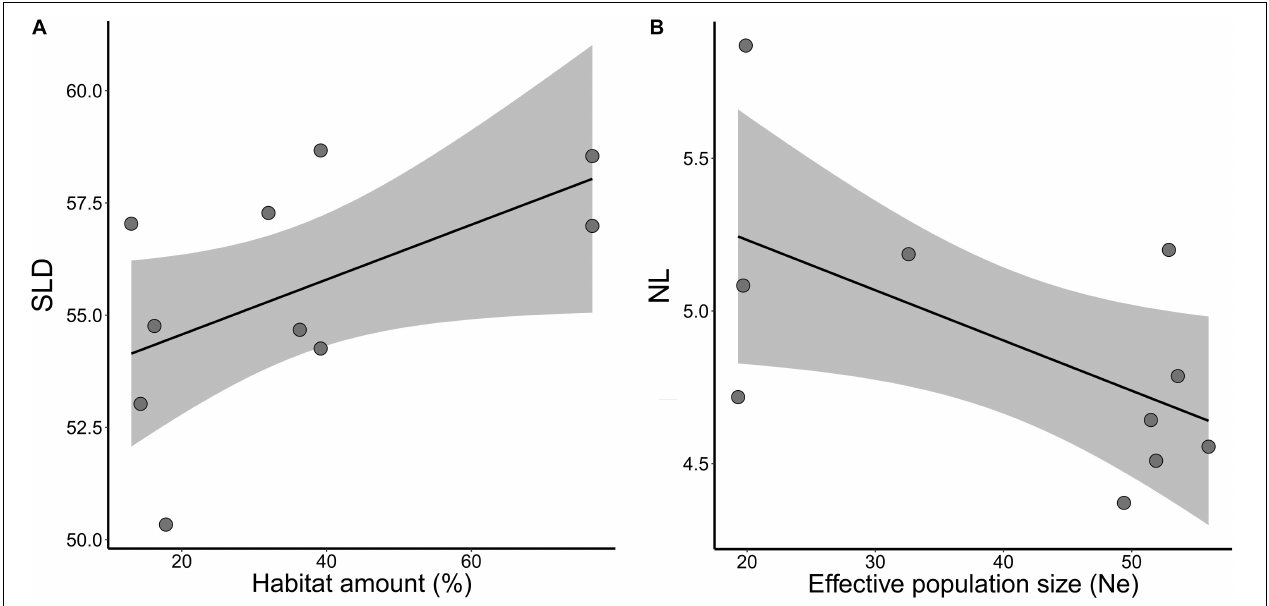
FIGURE 5 | Relationships of adaptive quantitative traits and habitat amount and effective population size ( Ne ) in five landscapes of Tabebuia aurea in the Brazilian Cerrado. (A) Mean seed longitudinal diameter (SLD) and habitat amount. (B) Mean number of leaves (NL) and effective population size ( N e ). Black line is the linear regression fit and shaded area the 95% confidence interval. All fits were marginally significant ( p <